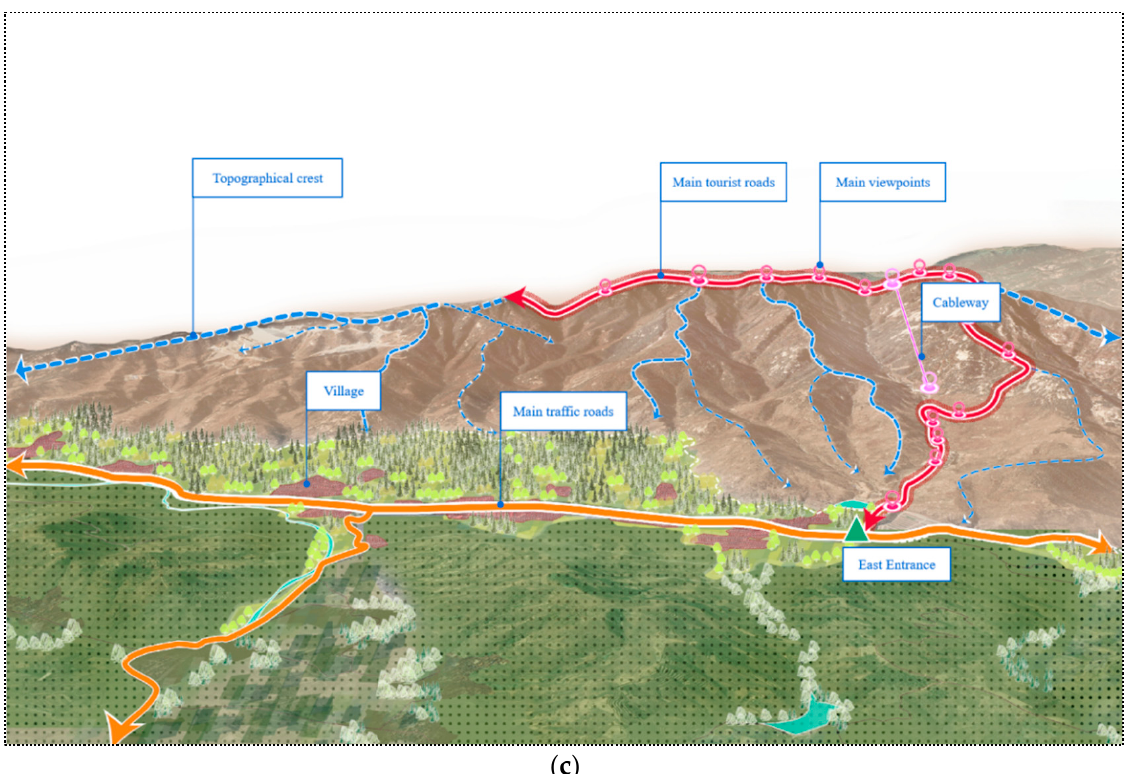
Figure 1. ( a ) The location, ( b ) land-use types, and ( c ) spatial-distribution patterns of the Tianmeng Mountain Scenic Spot.